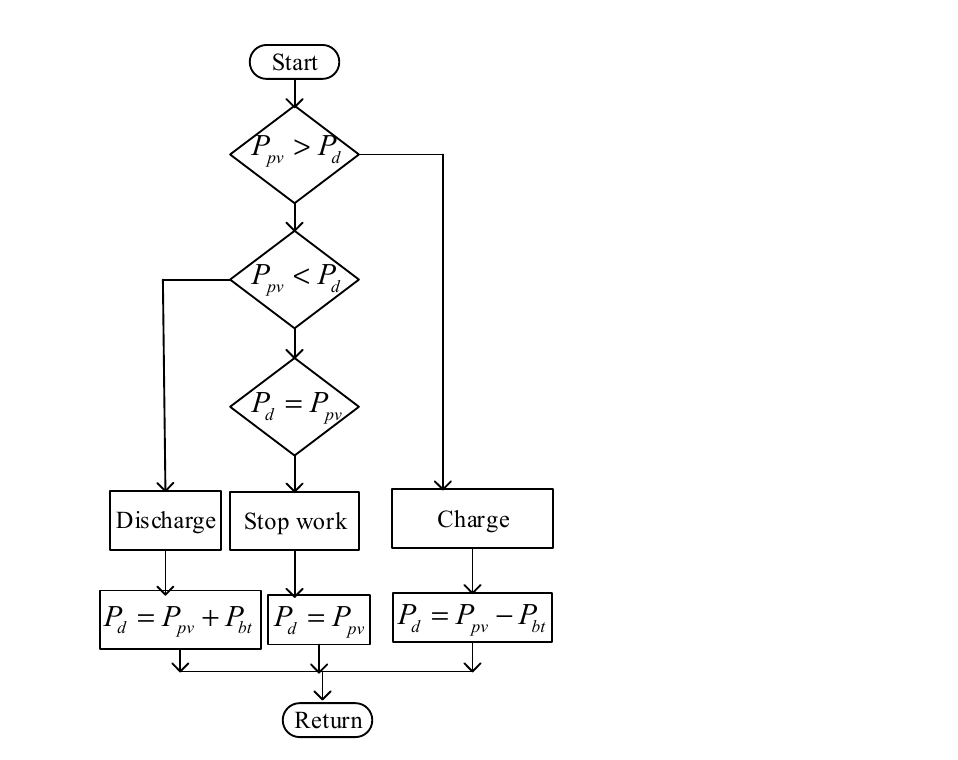
Figure 2. Energy management scheme of battery energy storage (BESS). In Figure 2 (cid:1842) (cid:3031) power represents the require for the system, (cid:1842) (cid:3029)(cid:3047) indicates the power of battery module and (cid:1842) (cid:3043)(cid:3049) is the power supplied by the PV panels.